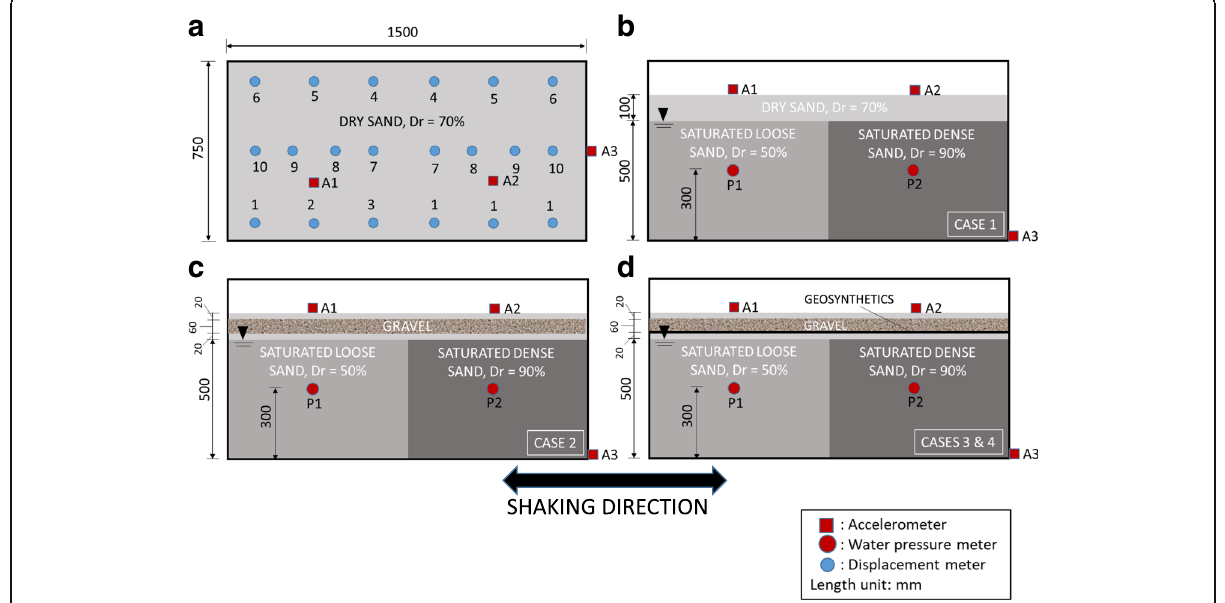
Fig. 3 a Plan view of the sandbox; b Side view Case 1; c Side view Case 2; d Side view Cases 3 and 4